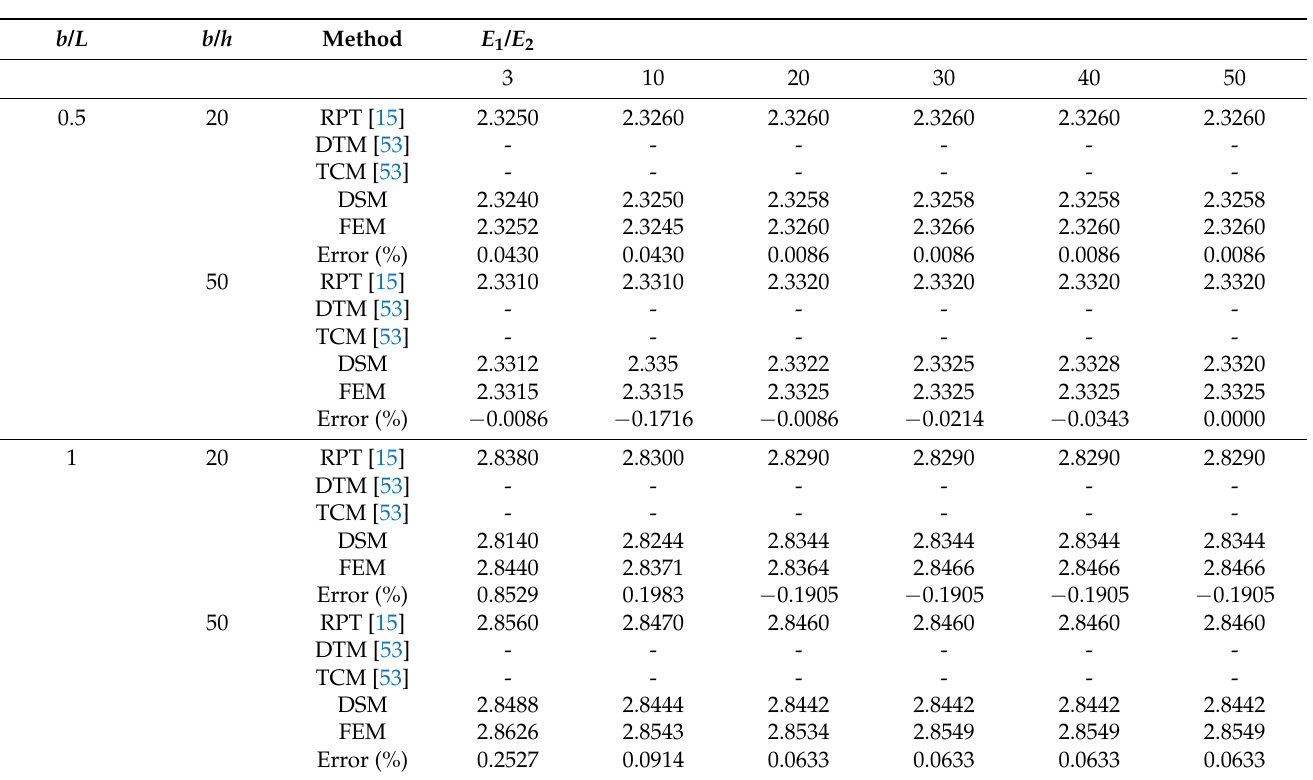
Table 8. Comparison of the fundamental frequency parameters plate with the FF boundary